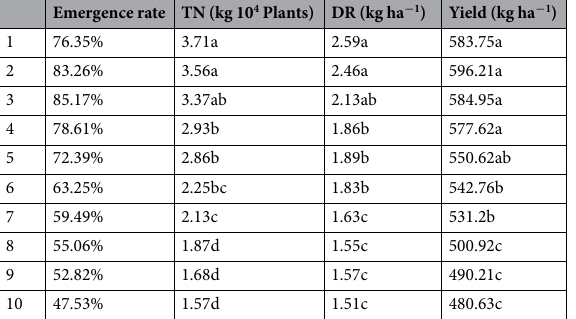
Table 4. Wheat seedling characteristics of different grades of cultivated land. TN is tiller number per plant at the beginning of wintering stage, and DR is dry weight per 10 4 plants. Within a column, means followed by the same letter are not significantly different at the 0.05 level of probability by students t